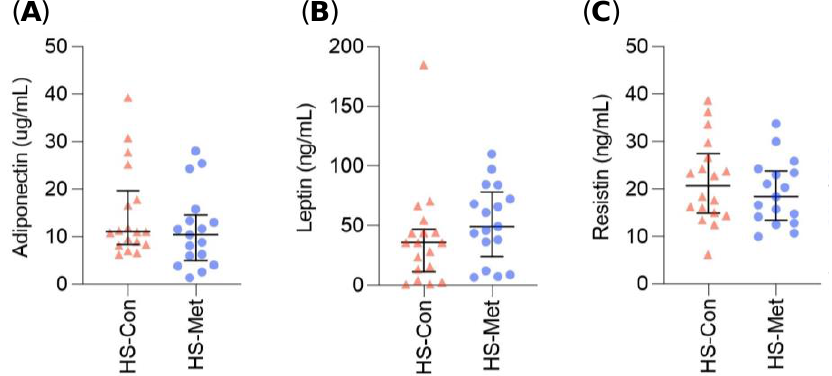
Figure 4. No statistically significant difference in serum adipokines between HS controls (HS-Con) and those on metformin (HS-Met). Serum levels of adipokines adiponectin ( A ), leptin ( B ), and resistin ( C ) were analysed using ELISA in 18 HS controls and 17 HS patients taking metformin. Graphs represent individual samples with median and IQR. Statistical significance was calculated using the Mann–Whitney test. IQR = interquartile range.